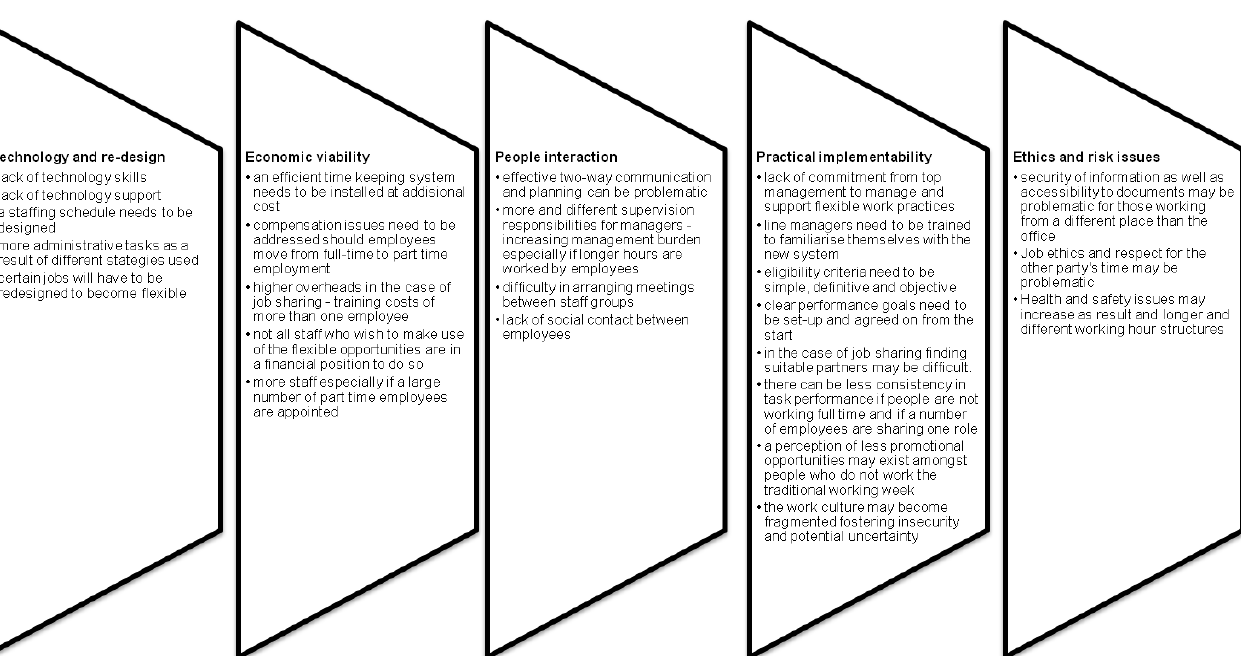
Table 3: Problems/challenges facing companies in implementing flexible work practices